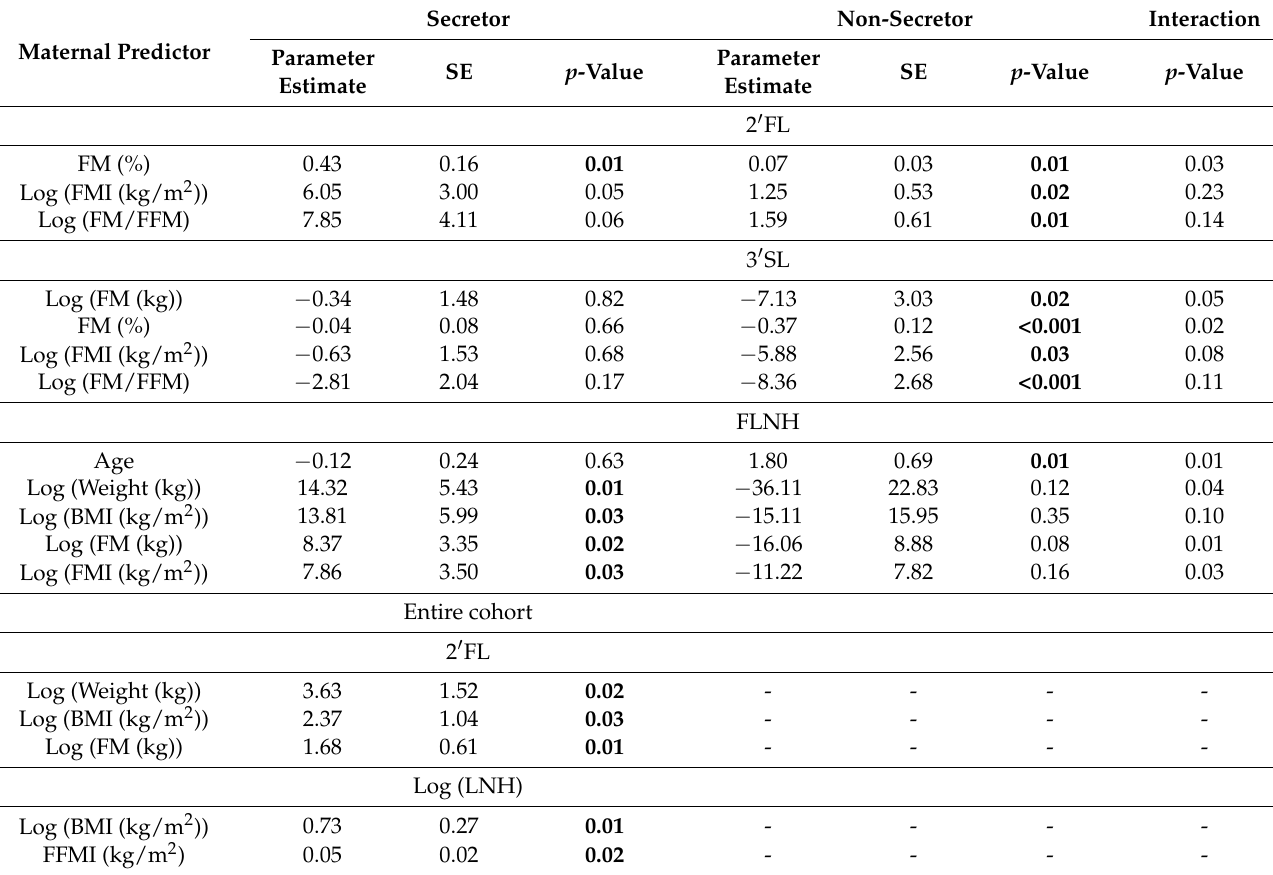
Table 1. Associations between maternal body composition and HMO